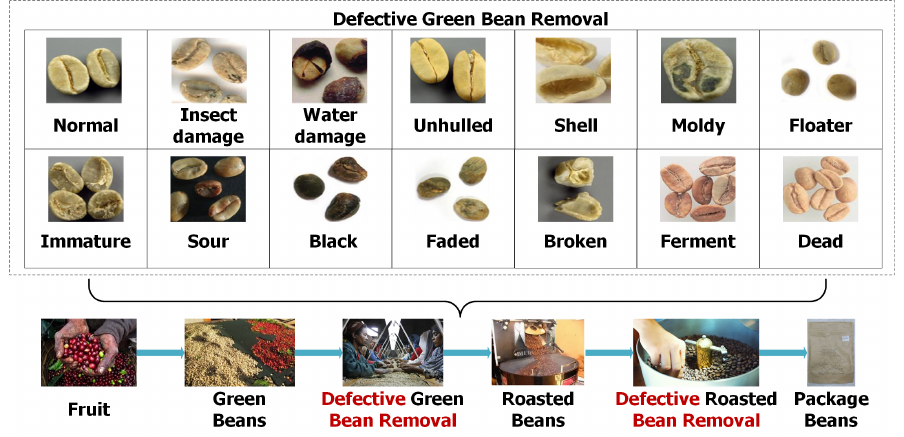
Figure 1. An illustration of production process from green beans to coffee bean